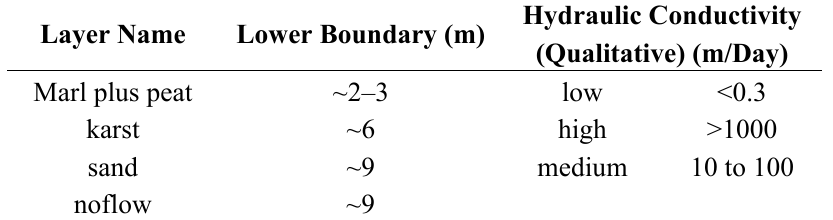
Table 1. Stratigraphy and hydraulic conductivities used for the Coot Bay Hammock. Parameter values are assumed from other